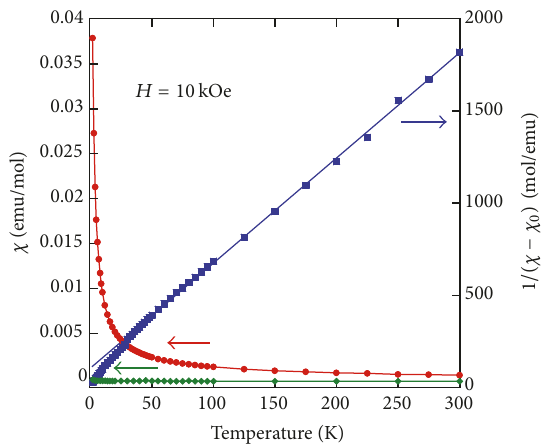
Figure 2: Temperature dependence of the magnetic susceptibility 𝜒 and inverse susceptibility 1/(𝜒−𝜒 0 ) for a -CeRu 2 Al 10 alloy. The green points and line are the temperature dependence of the magnetic susceptibility 𝜒 for a -LaRu 2 Al 10